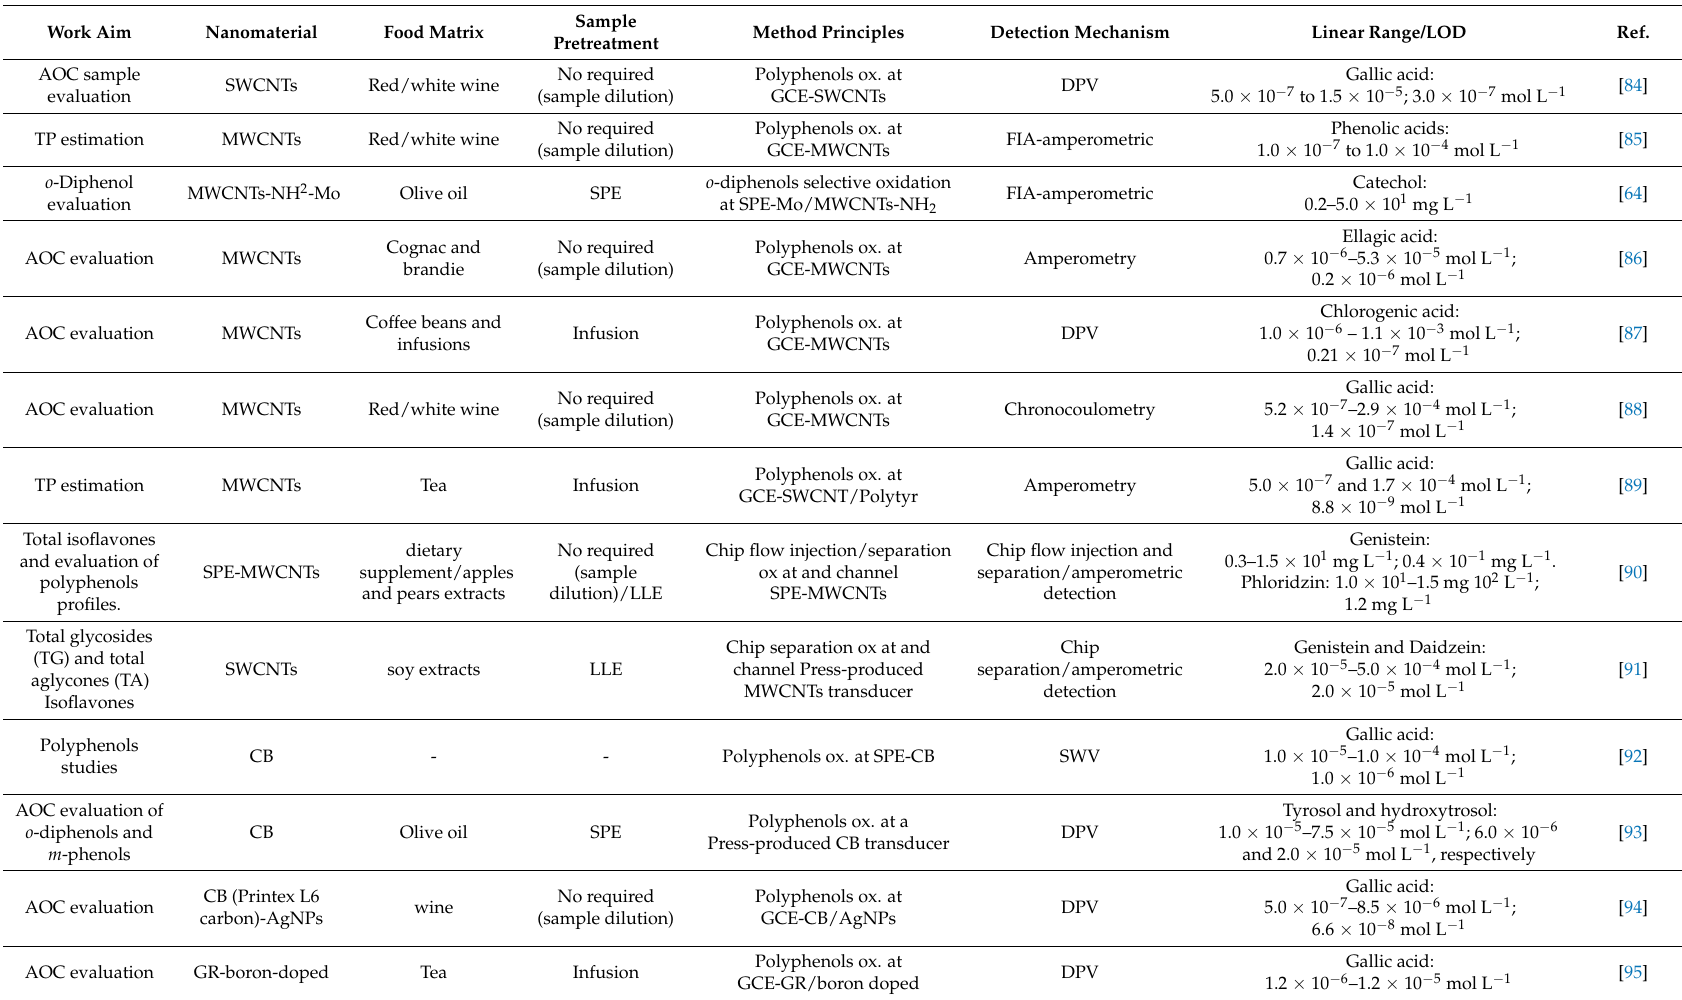
Table 2. Electrochemical sensors based on nanomaterial for food polyphenols evaluation: main features and